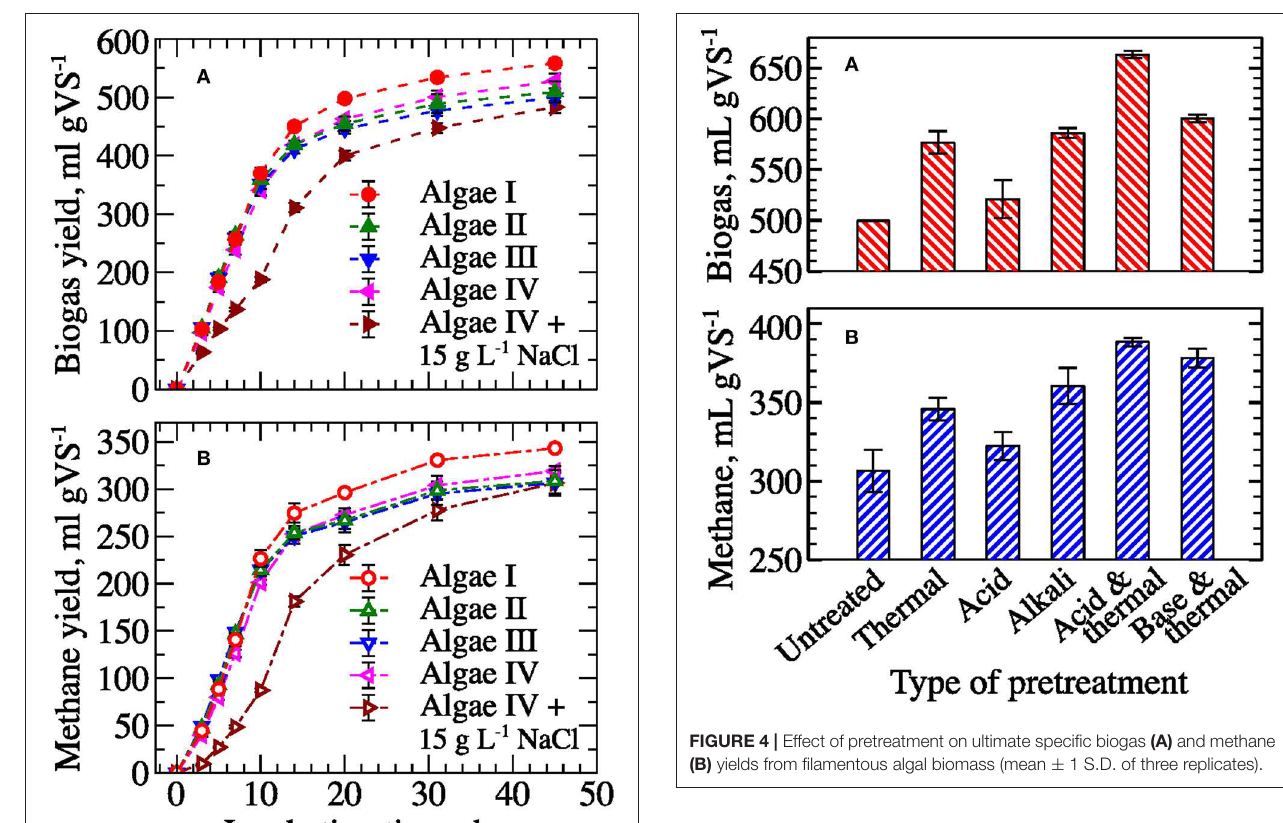
into methane (theoretical vs. observed yields) indicates that